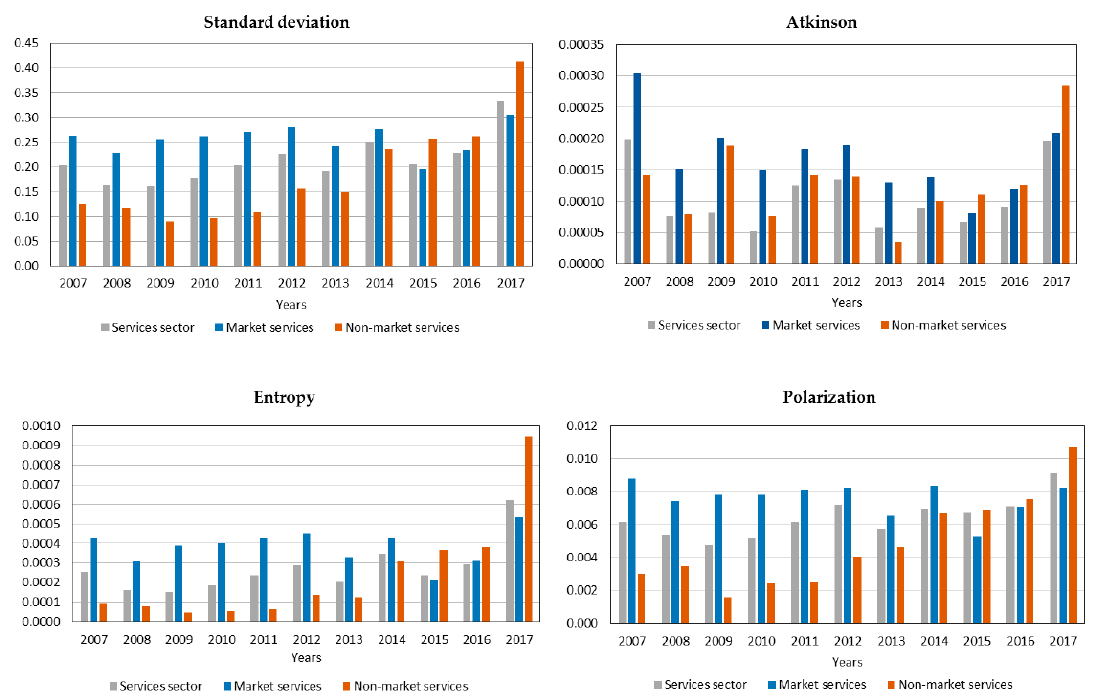
Figure 5. Inequality and polarization indices in provincial sectoral productivity of Ecuador 2007–2017. Source: Own elaboration based on the Regional Accounts of the BCE [46]; ENEMDU surveys from the INEC [47] (several years) and Distributive Analysis Stata Package